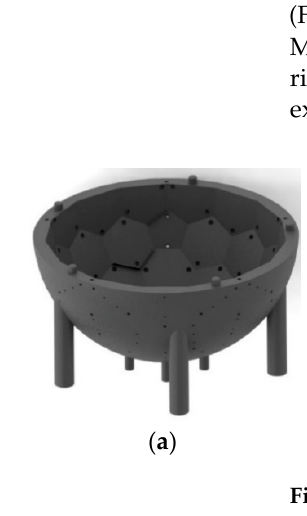
Figure 4. Stator poles and bearings: ( a ) assembled regular hexagonal pole unit showing tapped M6 threading for Hudson bearings; ( b ) M6 Hudson bearings assembled into the hexagonal poles; ( c ) wound stator pole ( N = 522 turns of 24 AWG magnet wire).